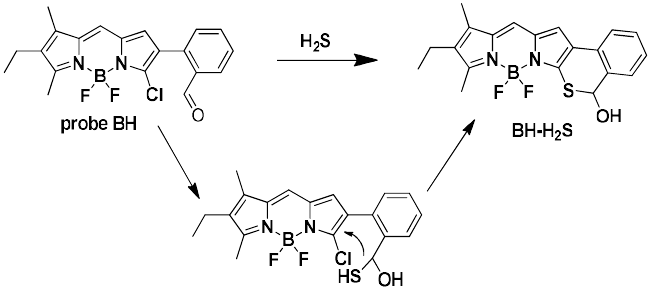
Figure 3. The 1 H-NMR ti tr ation of probe BH toward H 2 S in DMSO-d6 (400 MHz), ( a ) BH ; ( b ) BH + H 2 S.